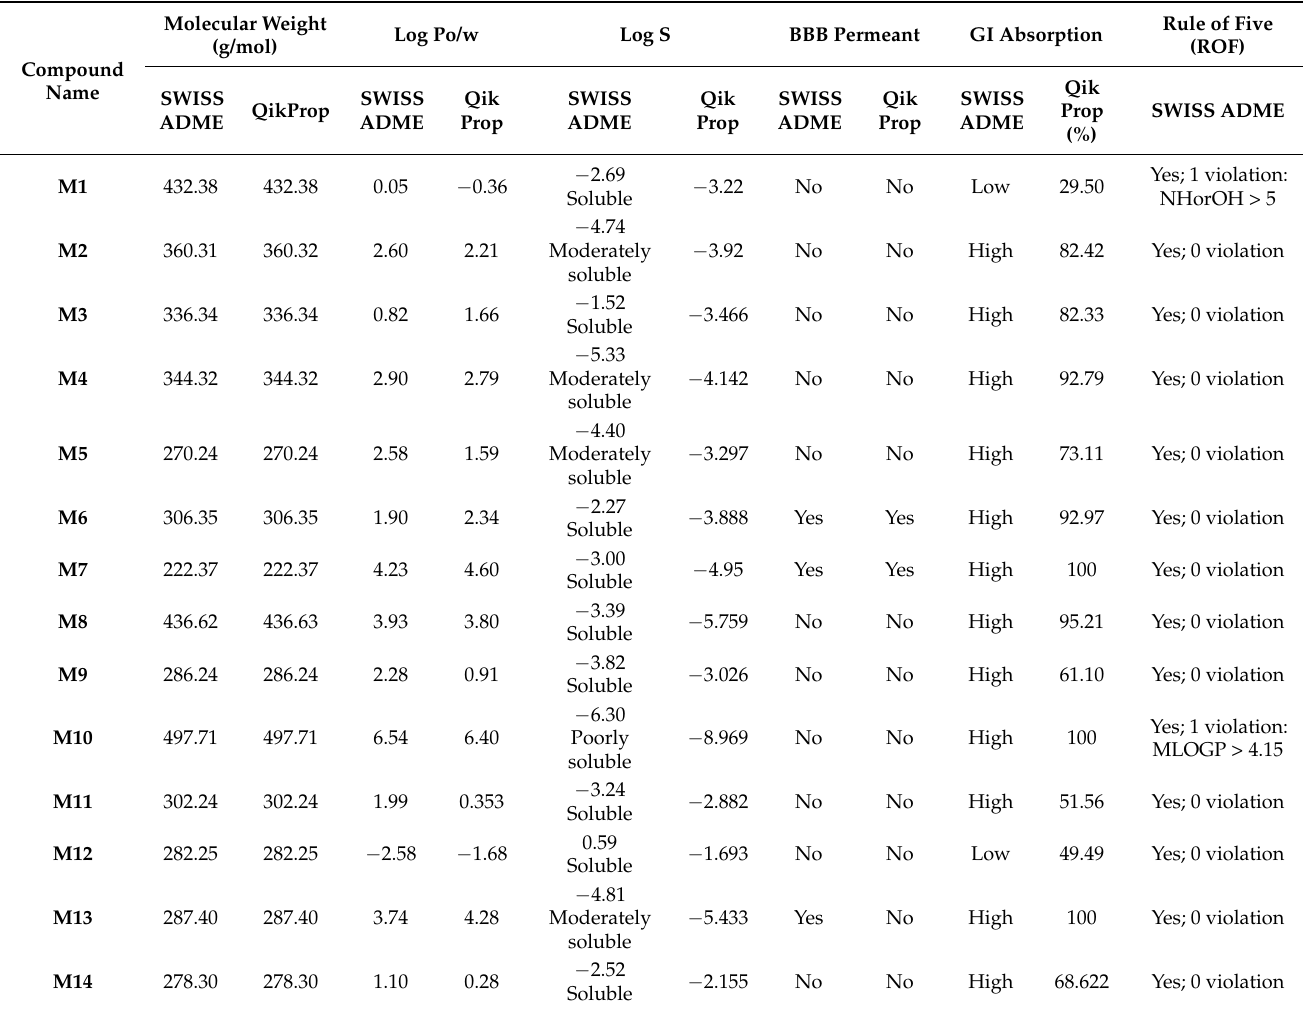
Table 6. The predicted ADME properties of A. fragrantissima flower dichloromethane extract-derived metabolites using SwissADME